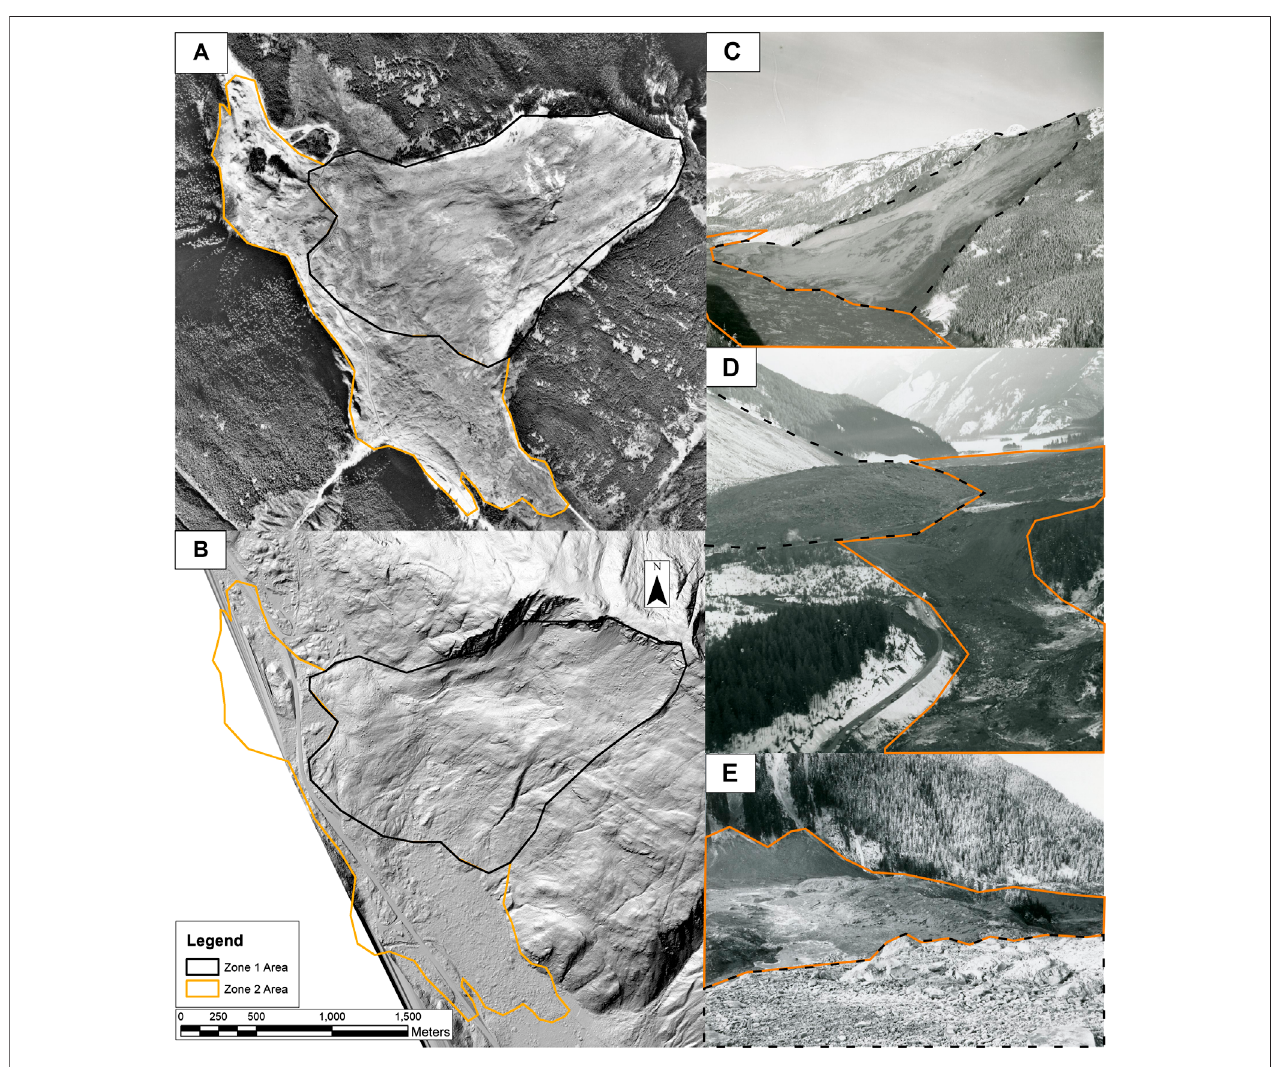
FIGURE 5 | Hope Slide (A) ortho image generated from aerial photographs taken in 1965, (B) bare-earth lidar hillshade from 2014 (data courtesy of BC MoTI), (C) oblique view of the slide, (D) oblique view of the west margin of the deposit area, and (E) view of the south side of the debris fi eld showing the transition from Zone 1 to Zone 2 deposits (photos C through E courtesy of BC